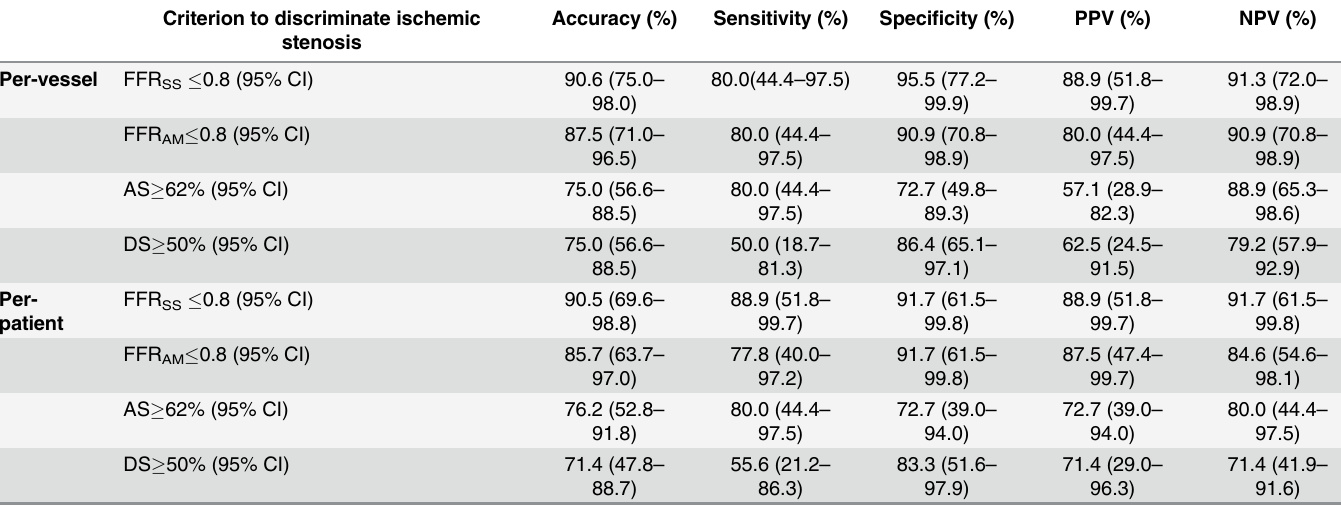
Table 3. Diagnostic performance of FFR SS , FFR AM , AS and DS compared to invasively measured FFR for discrimination of ischemic coronary ste- nosis (ischemic group, FFR (cid:1) 0.8; non-ischemic group, FFR > 0.8) Criterion to discriminate ischemic